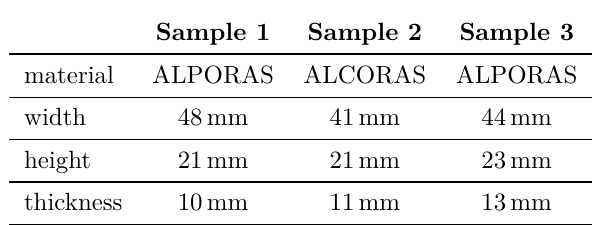
Table 1. Dimensions of the